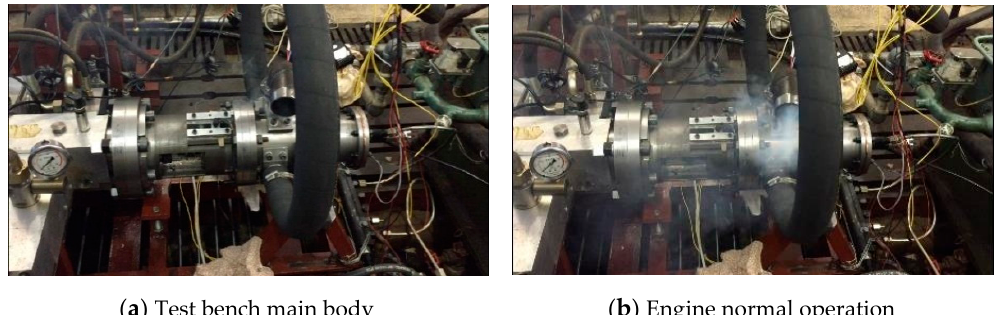
Figure 25. HFPE of Jilin University [62].